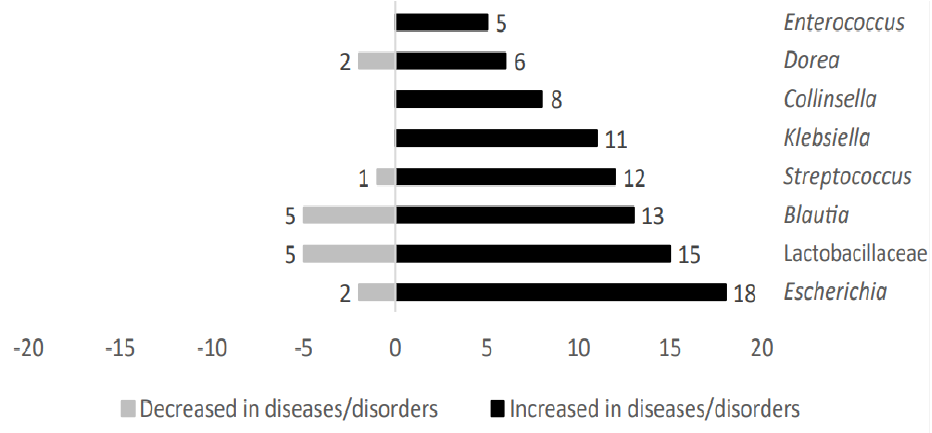
Figure 3. Analysis of main taxa stratified according to high representativeness in metabolic − related diseases patients.